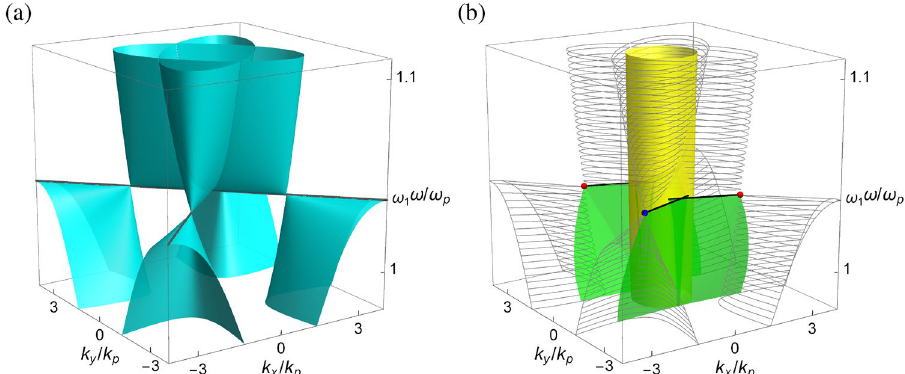
Figure 3. Dispersion of ( a ) bulk modes and ( b ) surface modes in the frequency-wave vector space for the pseudochiral metamaterial with ε ∞ = 4 , µ ∞ = 3 , � µ = 0.522 , � γ = ± 0.723 and ω 0 /ω p = 0.8 . Wave vector components are scaled by k p = ω p / c . In ( a ), dark gray lines are bulk modes at the Weyl frequency. In ( b ), bulk modes at constant frequencies are outlined in gray mesh. Yellow cylinder is the dispersion surface of vacuum. Blue and red dots are the Weyl points with opposite chirality. Black lines are the Fermi